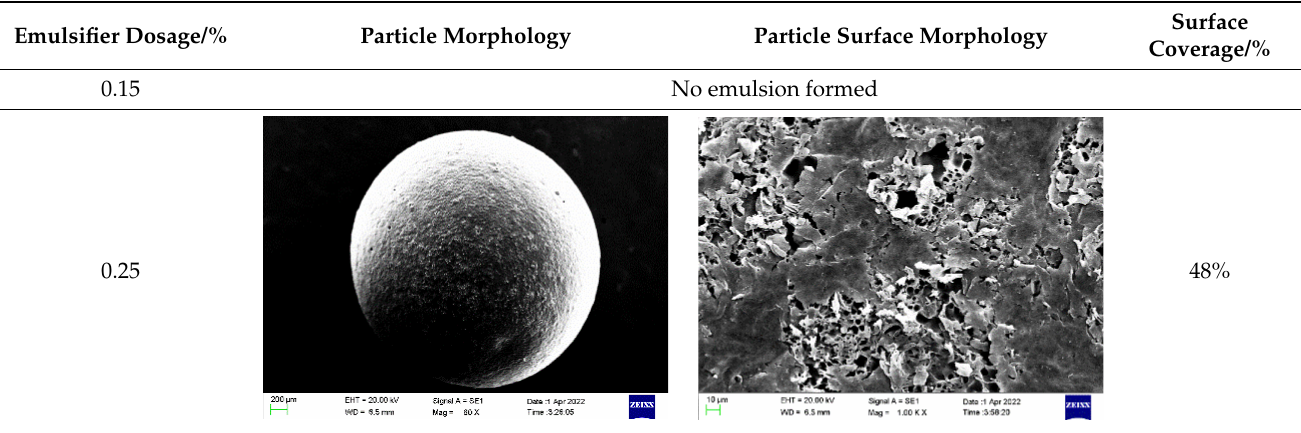
Table 2. Surface coverage of proppants obtained with different emulsifier